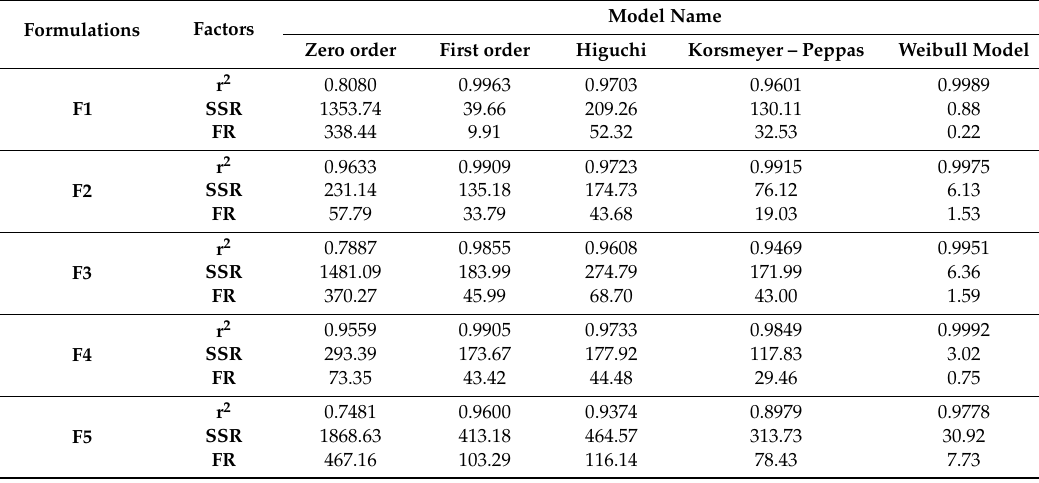
Figure 4. In vitro release profiles of nebivolol from prepared gels (F1–F8) at various time intervals. Data expressed as average ± SD (n = 6). Table 3. Model fitting for prepared nebivolol hydrogel